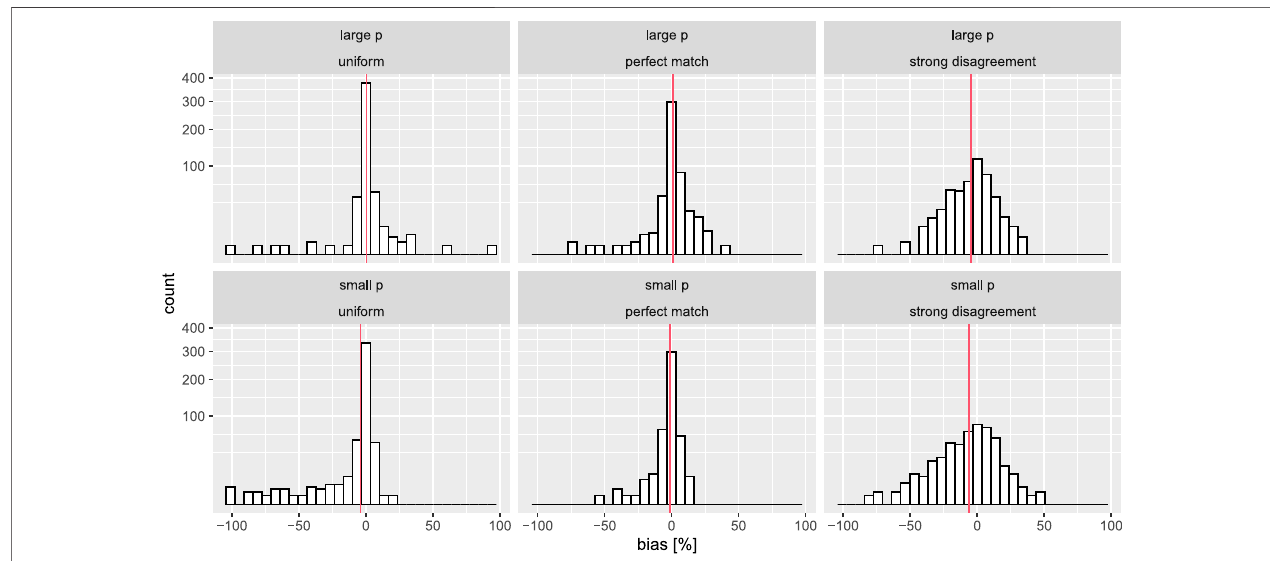
FIGURE 4 | Variation of the bias in the estimate of the superior arm. The red vertical lines depict the empirical average of the bias.